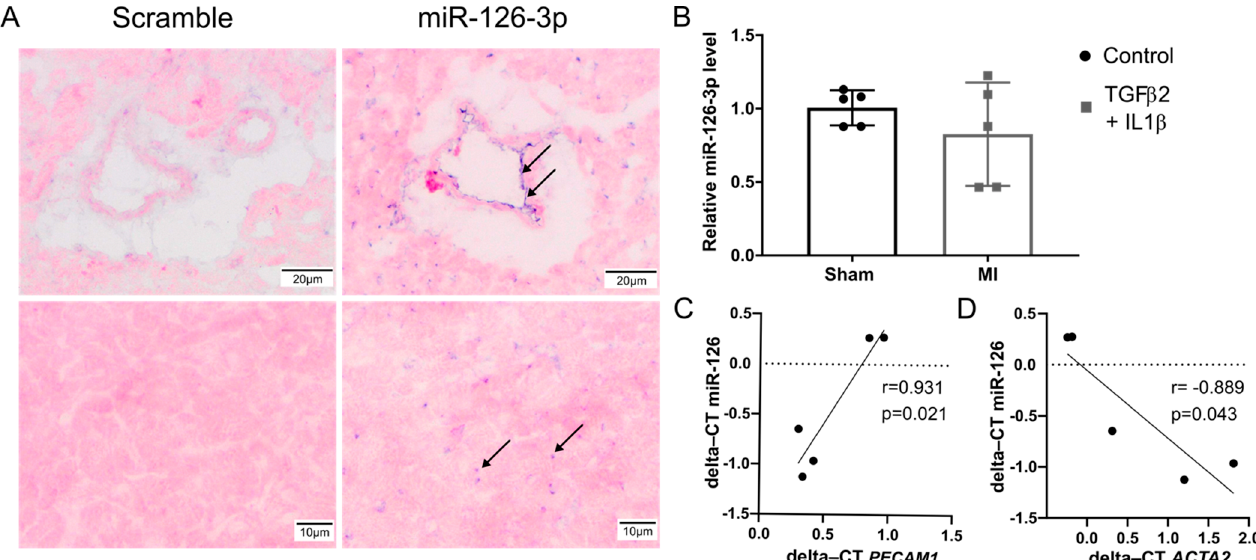
Figure 5. MiR126-3p is expressed in cardiac endothelial cells and is correlated with EndMT. ( A ) In situ hybridisation of miR-126-3p (40 nM) or scramble double-DIG labelled LNA probes (40 nM) was performed on frozen sections of the healthy mouse heart. Pictures were focused on vessel and myocardium ( n = 3). ( B ) Analysis of miR126-3p in sham and MI heart was assessed by RT-qPCR. Expression was normalised to the expression of the housekeeping gene SnoRNA 202 and errors bars are standard error of the mean. ( n = 5). ( C ) Correlation of CD31 gene expression (PECAM1) to miR-126-3p expression in fibrotic heart. ( D ) Correlation of α SMA gene expression (ACTA2) to miR-126-3p expression in the fibrotic heart. Statistical significance was calculated by unpaired t -Test.